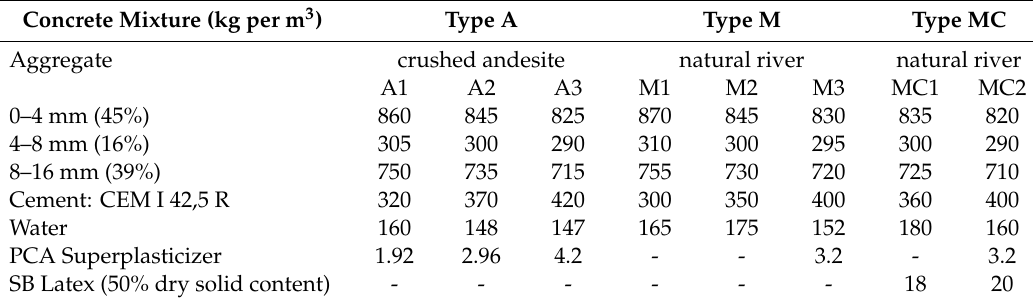
Table 1. Mixture proportion of di ff erent concrete batches.